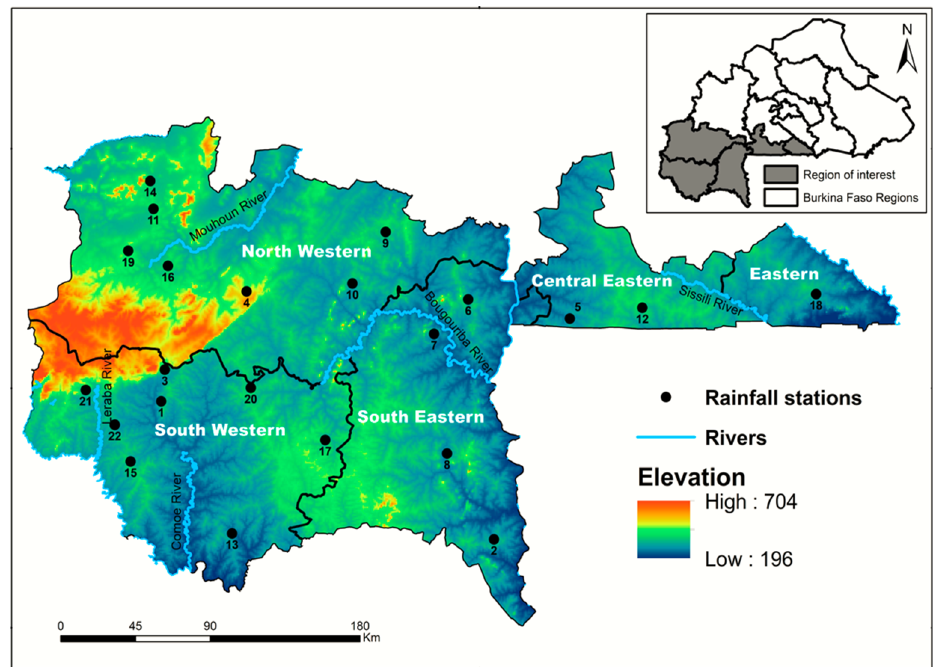
Figure 1. Topography, main rivers, and rainfall stations of the study area are located in the southern part of Burkina Faso. Eastern, central eastern, northwestern, southeastern and southwestern are administrative areas of Burkina Faso corresponding to Nahouri, Sissili, Haut-Bassins, Sud-Ouest, and Cascades.